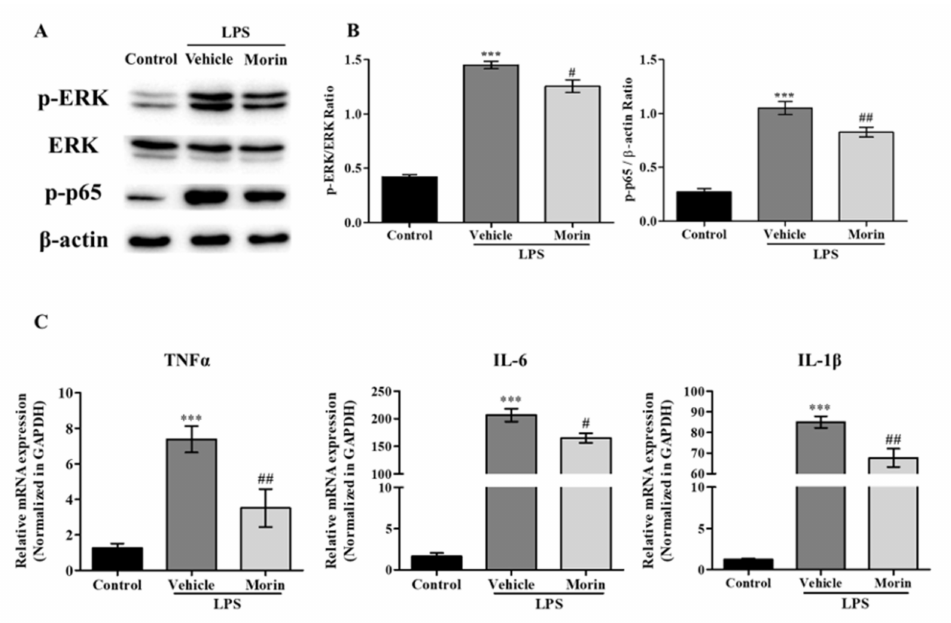
Figure 6. Morin effectively suppressed glial activations on microglia. ( A ) Western blot analysis showed that morin inhibited the LPS-induced phosphorylations of ERK and p65 in primary microglia ( n = 3). ( B ) Quantitative densitometric analysis of Western blots. β -Actin was used as a loading control. Data are presented as means ± SEMs. *** p < 0.001 vs. control, ## p < 0.01 and # p < 0.05 vs. vehicle. ( C ) Real time-PCR showed that morin significantly reduced LPS-induced increases in inflammatory cytokines levels. Data are presented as means ± SEMs. *** p < 0.001 vs. control, ## p < 0.01 and # p < 0.05 vs.